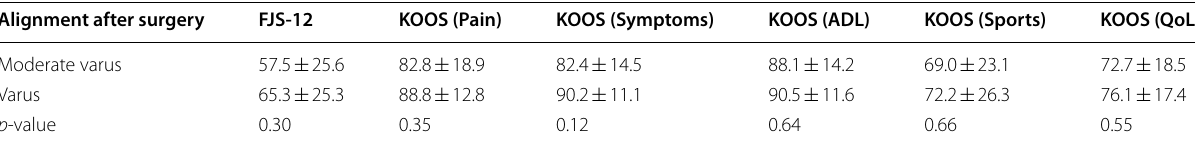
Table 3 Comparison of postoperative value for each patient-reported outcome measure between the moderate varus alignment group and the varus alignment